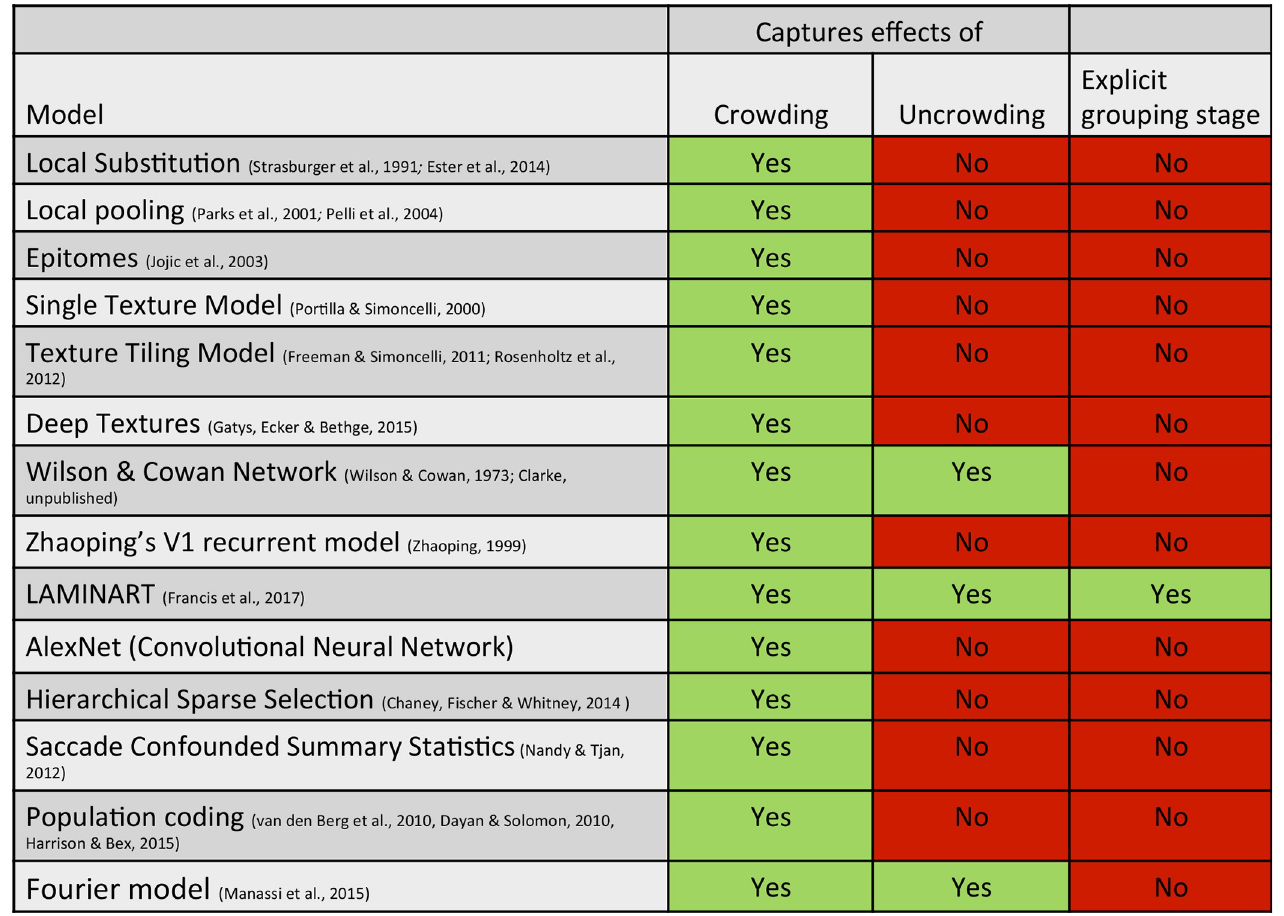
Fig 15. Model comparison. All models produce crowding, but only the Fourier, Wilson and Cowan and LAMINART models produce uncrowding. The Fourier and the Wilson and Cowan model overfit and thus do not capture general principles. The LAMINART is the only model that explicitly computes grouping like aspects and segments the image into different